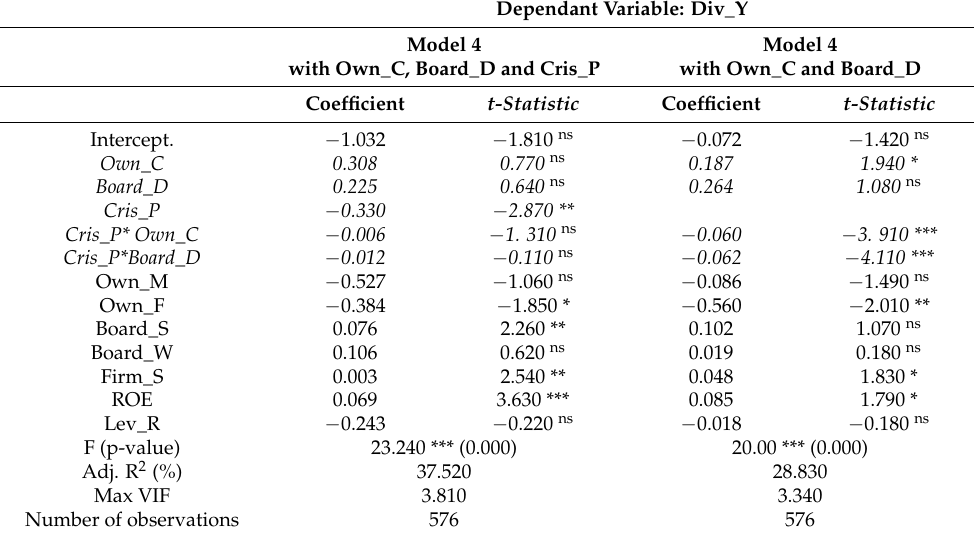
Table 7. Alternative regression for model